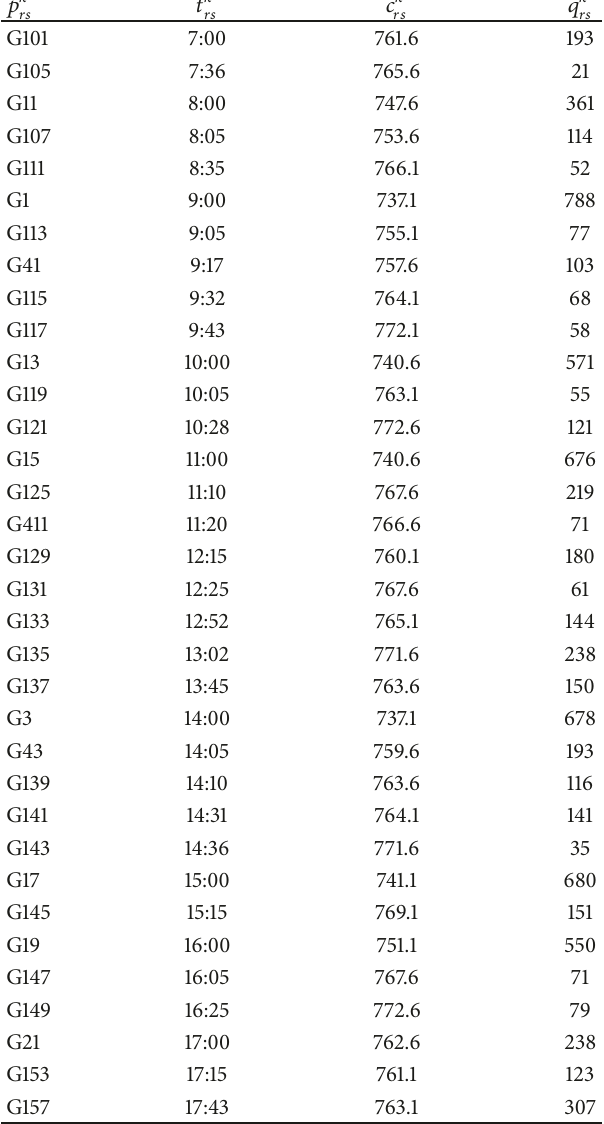
Table 1: The data of each itinerary of OD pair Beijing-Shanghai. 𝑝 𝑘